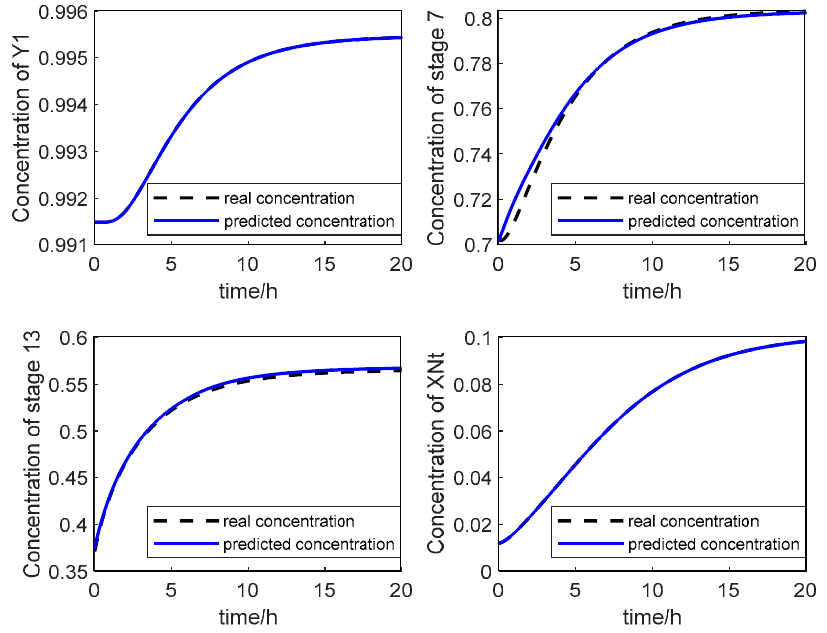
Figure 9. Dynamic tracking of product concentration at the 1st, 7th, 13th and 20th trays when F +10%.